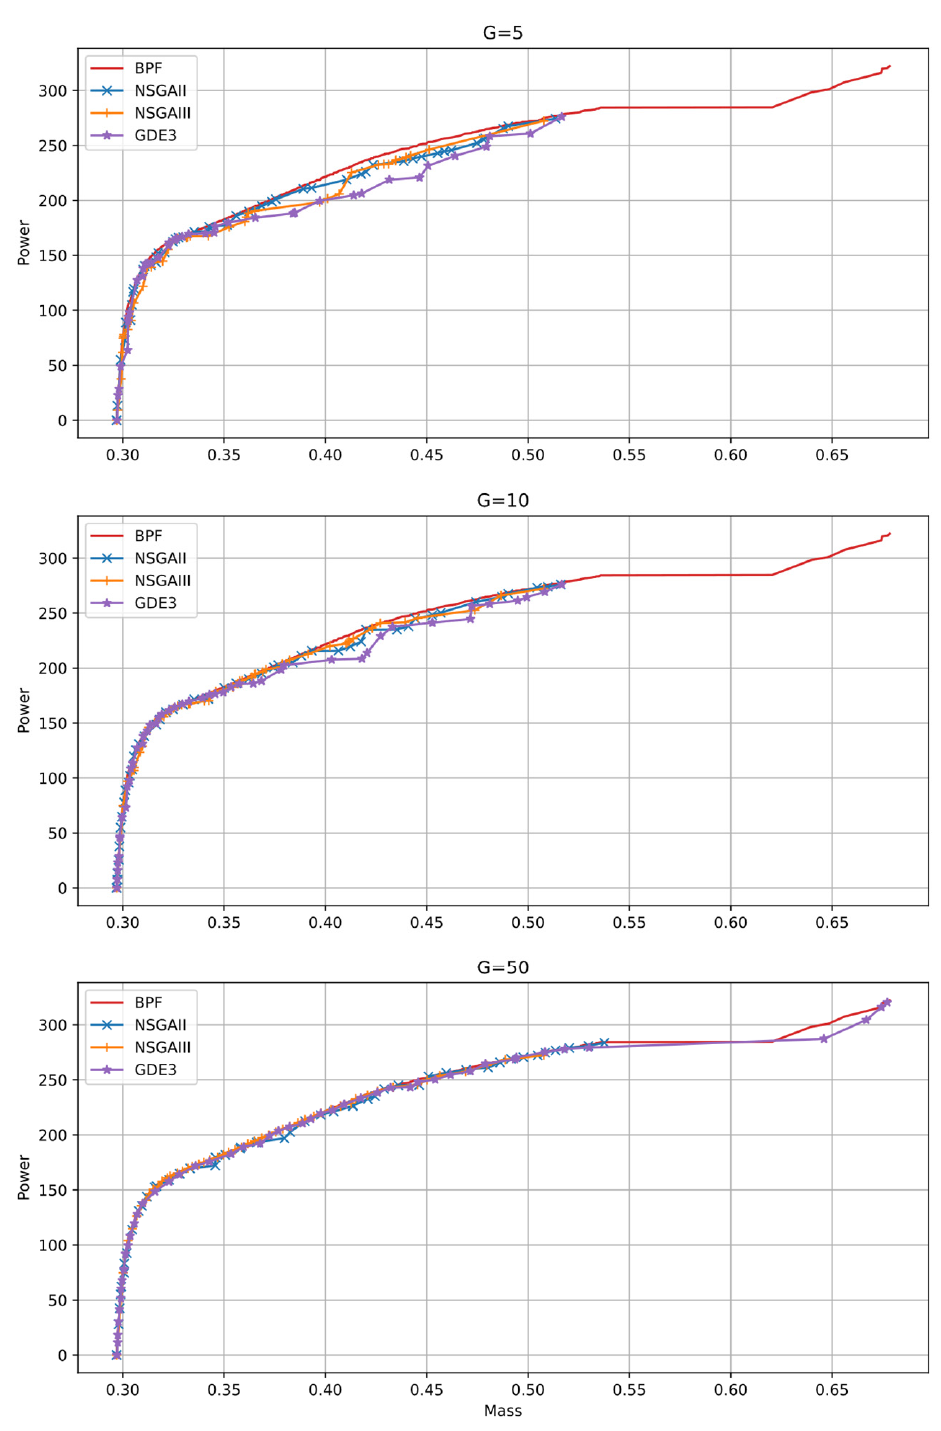
Figure 6. Pareto fronts produced by NSGA-II, NSGA-III and GDE3 at generations 5, 10 and 50.